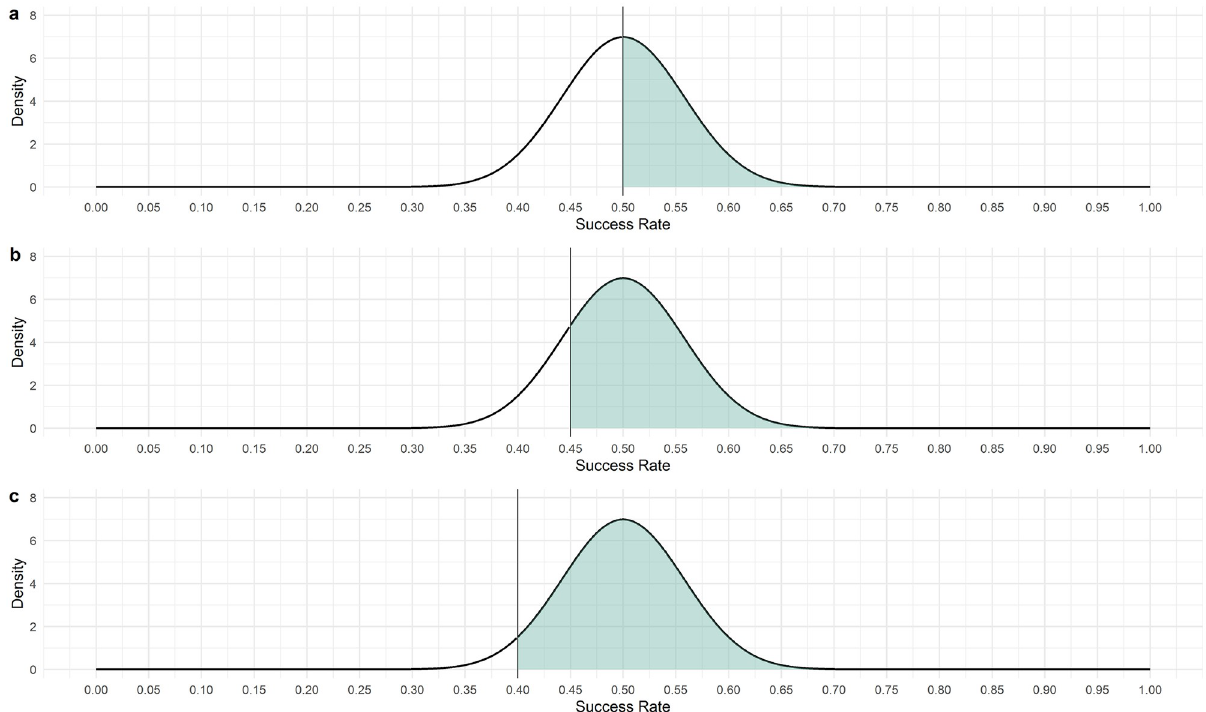
Fig 8. Beta distributions corresponding to the posterior we would observe if a Beta(1,1) prior and a sample size of 75 was used and the observed response rate would equal 0.5. Panel a: The posterior probability for a success rate greater or equal to 0.5 is 50%. If in our Bayesian decision rules we set a target of 0.5 and require a confidence of 50%, for large sample sizes we will graduate compounds with true responder rate of 0.5 in 50% of the cases, i.e. achieve a power of 50%. Panel b: The posterior probability for a success rate greater or equal to 0.45 is 81%. If in our Bayesian decision rules we set a target of 0.45 and require a confidence of 81%, for large sample sizes we will graduate compounds with true responder rate of 0.5 in 50% of the cases, i.e. achieve a power of 50%. Panel c: The posterior probability for a success rate greater or equal to 0.40 is 96%. If in our Bayesian decision rules we set a target of 0.40 and require a confidence of 96%, for large sample sizes we will graduate compounds with true responder rate of 0.5 in 50% of the cases, i.e. achieve a power of 50%. In order to achieve larger power values, required confidences and target success rates need to be